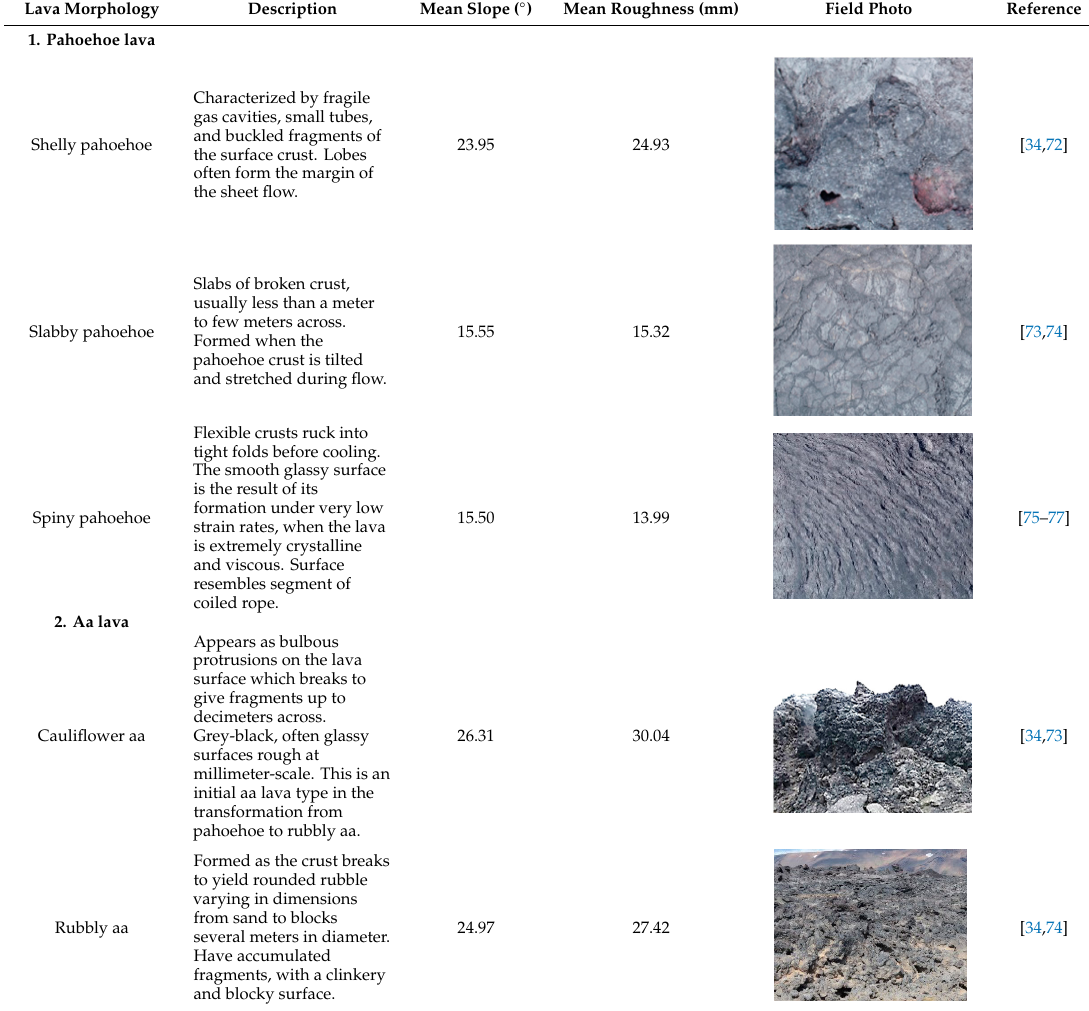
Table 2. Description of the lava morphology present in the study area.